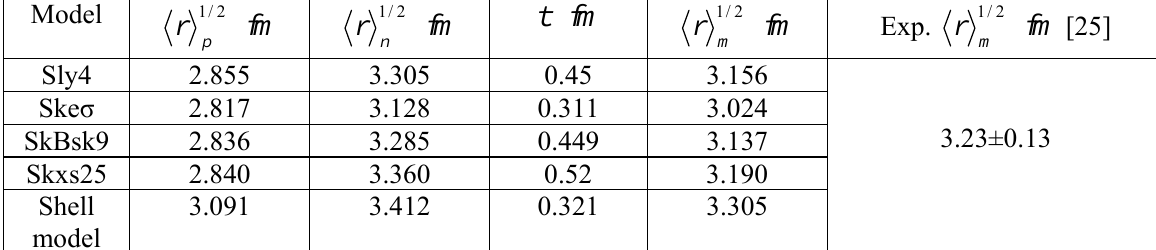
Table 4: The values of rms radii in fm of 26 F